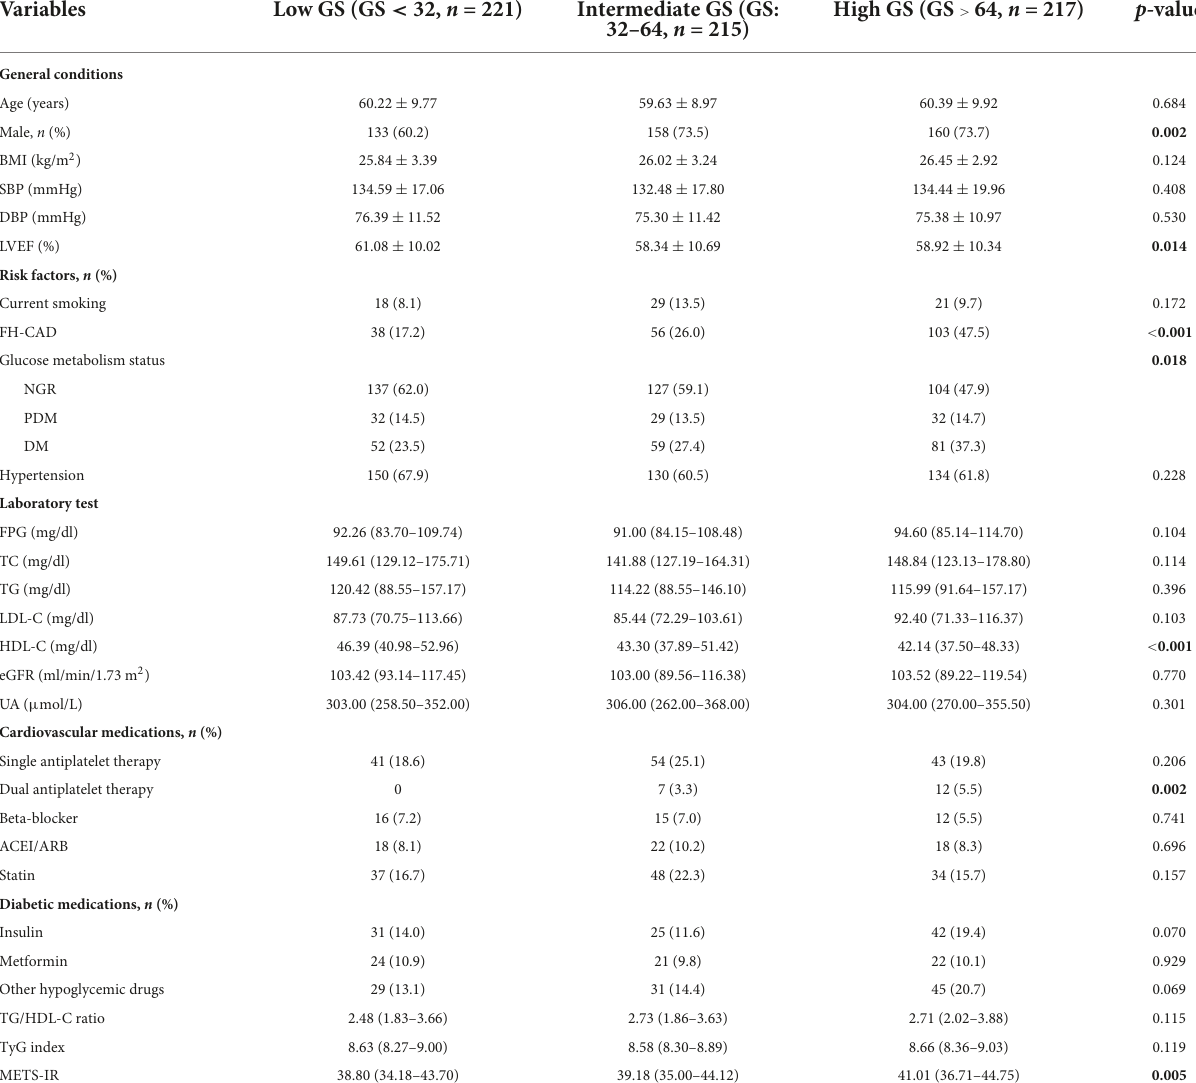
TABLE 2 Baseline characteristics of the study population according to the tertile of the Gensini